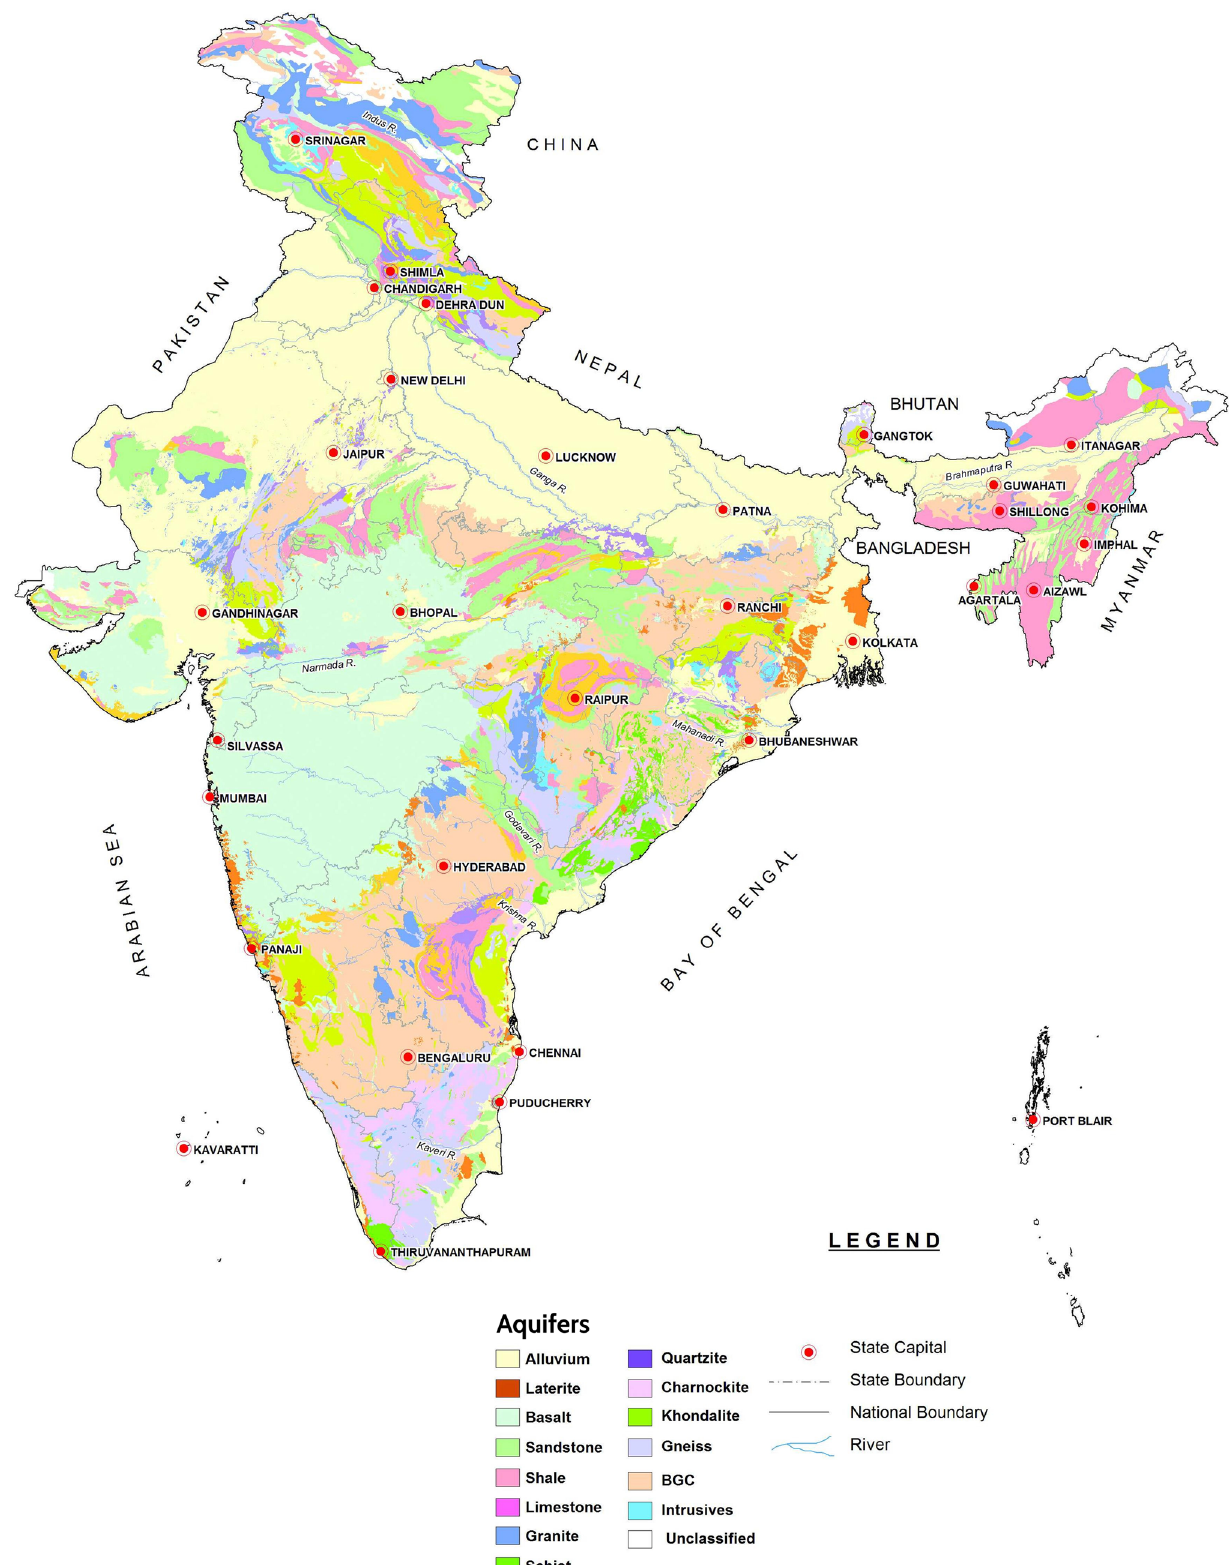
Fig. 2 Principal aquifers of India ( Source http:// cgwb. gov.